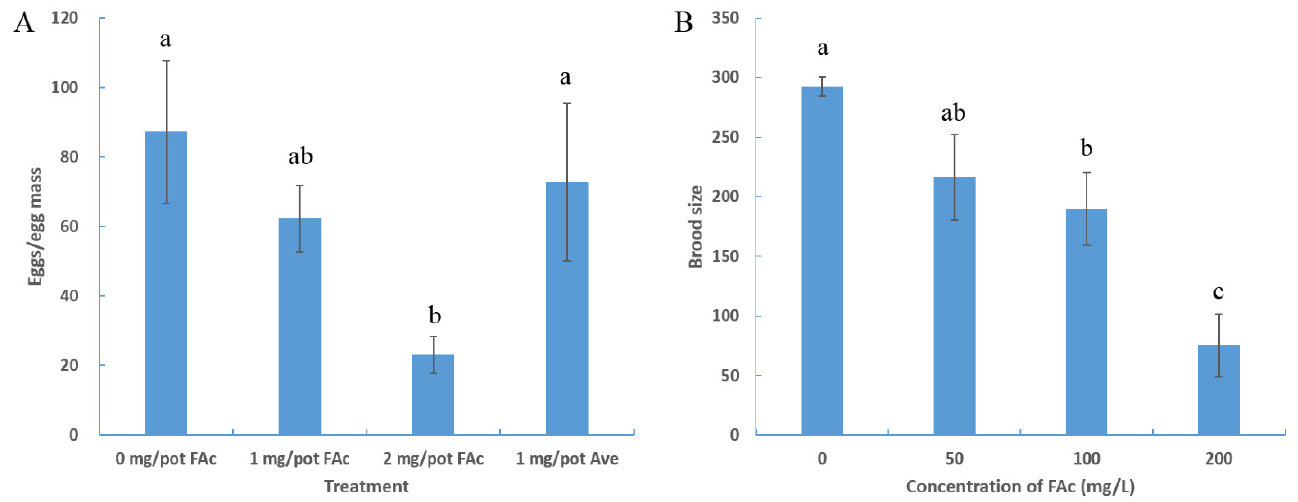
Figure 2. FAc inhibited nematode reproduction. ( A ) Number of M. incognita eggs in an egg mass on tomato roots after treatment with FAc or avermectin (Ave); data are shown as the mean ± standard error ( n = 5). ( B ) Brood size of C. elegans immersed in FAc solution in various concentrations for 72 h. Data are shown as the mean ± standard error ( n = 3), and different lowercase letters indicate significant difference among treatments by LSD test ( p < 0.05).